Question: What does this figure show? Answer in one sentence.
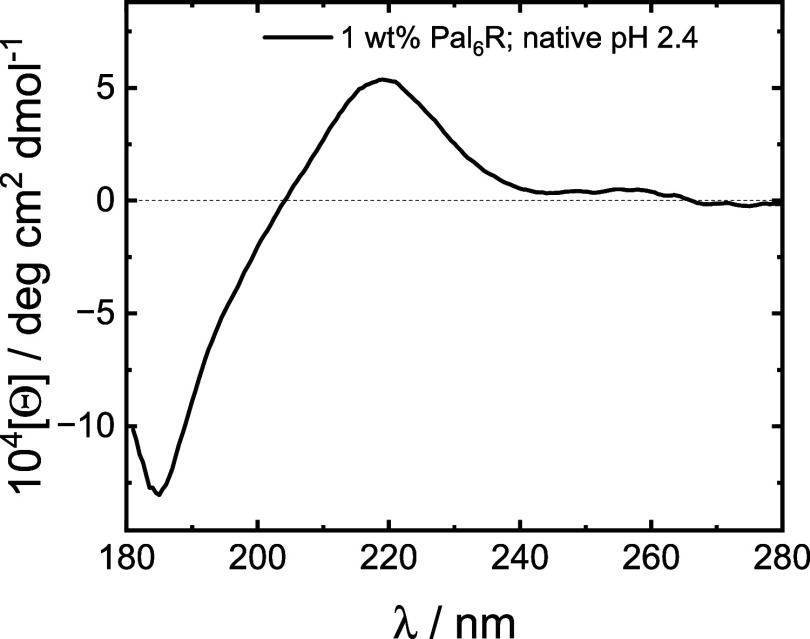
Answer: Circular dichroism spectrum for 1 wt % solution at pH 2.4.